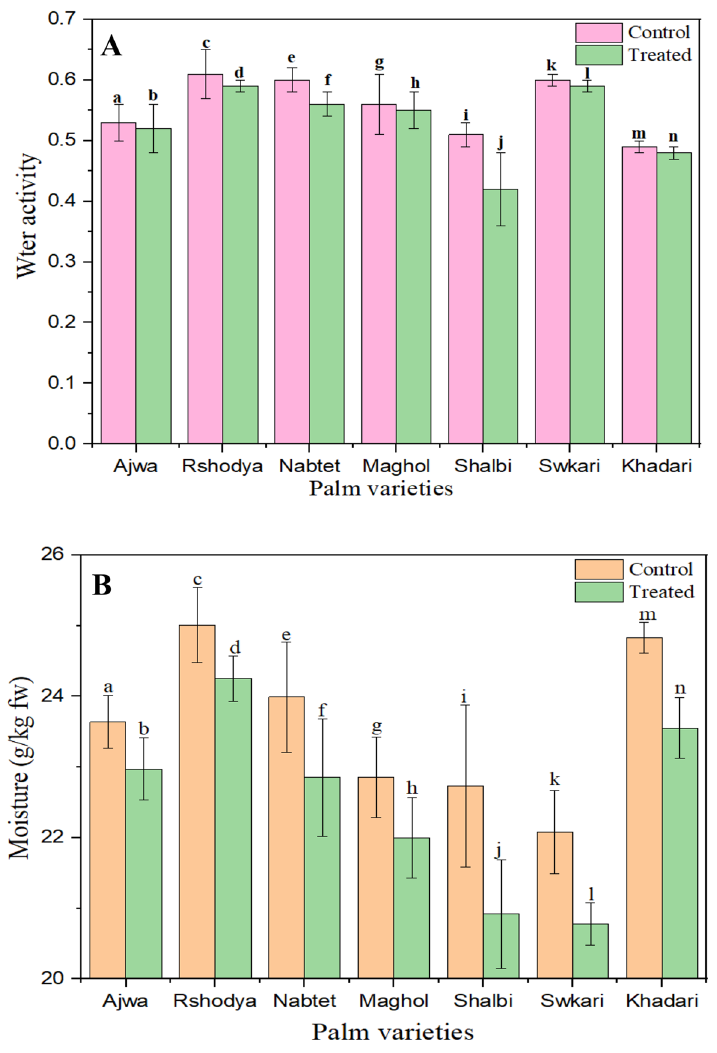
Figure 4. The influence of SDBD on Water activity, P value = 0.016 ( A ), and Moisture, P value = 0.002 ( B ) of Palm dates